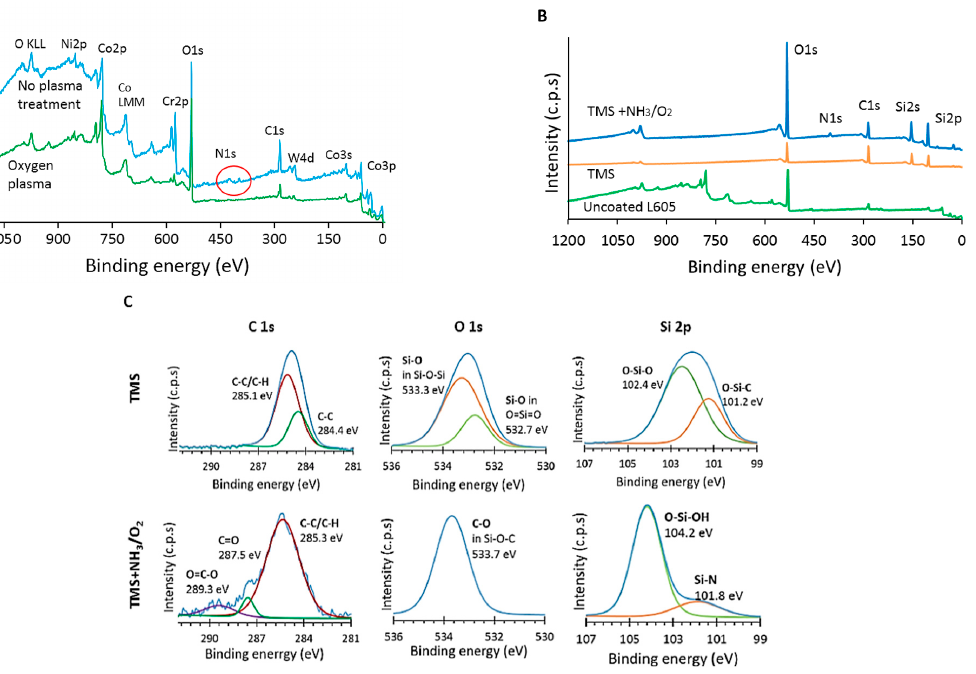
Figure 2. ( A ) XPS survey spectra for uncoated L605 surfaces treated with and without oxygen plasma, n = 3. Red circle emphasizes location of N 1s peak. ( B ) XPS survey spectra for uncoated L605, TMS plasma nanocoatings, and TMS+NH 3 /O 2 plasma nanocoatings, n = 3. ( C ). XPS core-level spectra, n = 3. TMS stands for TMS plasma-nanocoated L605, and TMS+NH 3 /O 2 stands for TMS plasma-nanocoated L605 with NH 3 /O 2 plasma post-treatment. Table 1. XPS surface atomic percentages (at.%) of uncoated L605 before and after oxygen (O 2 ) plasma treatment, n = 3.